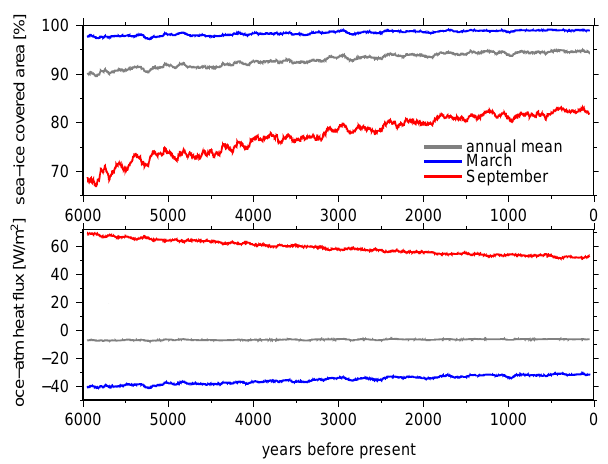
Fig. 5. Upper panel: percentage of sea-ice covered area in the Arctic Ocean, lower panel: atmosphere-ocean heat flux in W/m 2 - positive values from the atmosphere to the ocean. Both panels show 100 year running means.